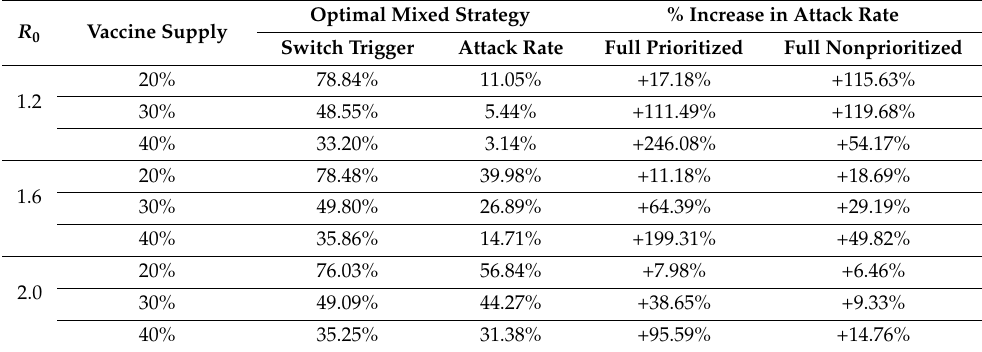
Figure 8. In this figure we compare the overall attack and mortality rates under the optimal switch triggers against different dispensing throughput efficiency levels at the vaccine clinics. 𝑅 0 = 1.2, initial infection is 0.5%. Solid curves denote attack rates; dotted curves denote mortality rates. Table 1. Optimal switch trigger for mixed strategy under different vaccine supply levels and basic reproduction numbers, the associated attack rates achieved; and their comparison to the full prioritized and the full nonprioritized